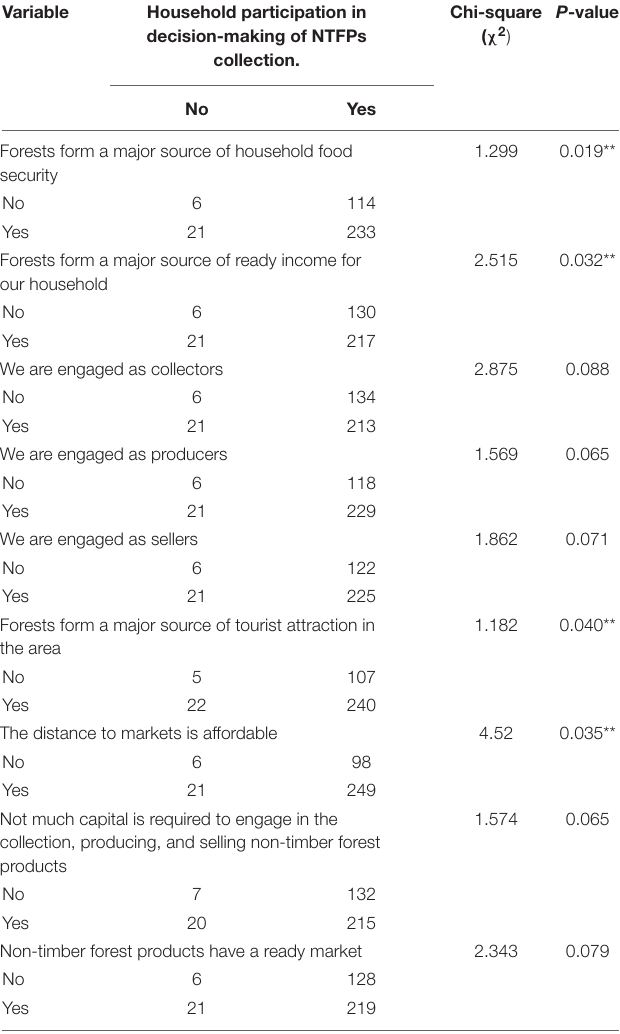
TABLE 3 | Economic factors characterizing the dependence on non-timber forest products. Variable Household participation in decision-making of NTFPs